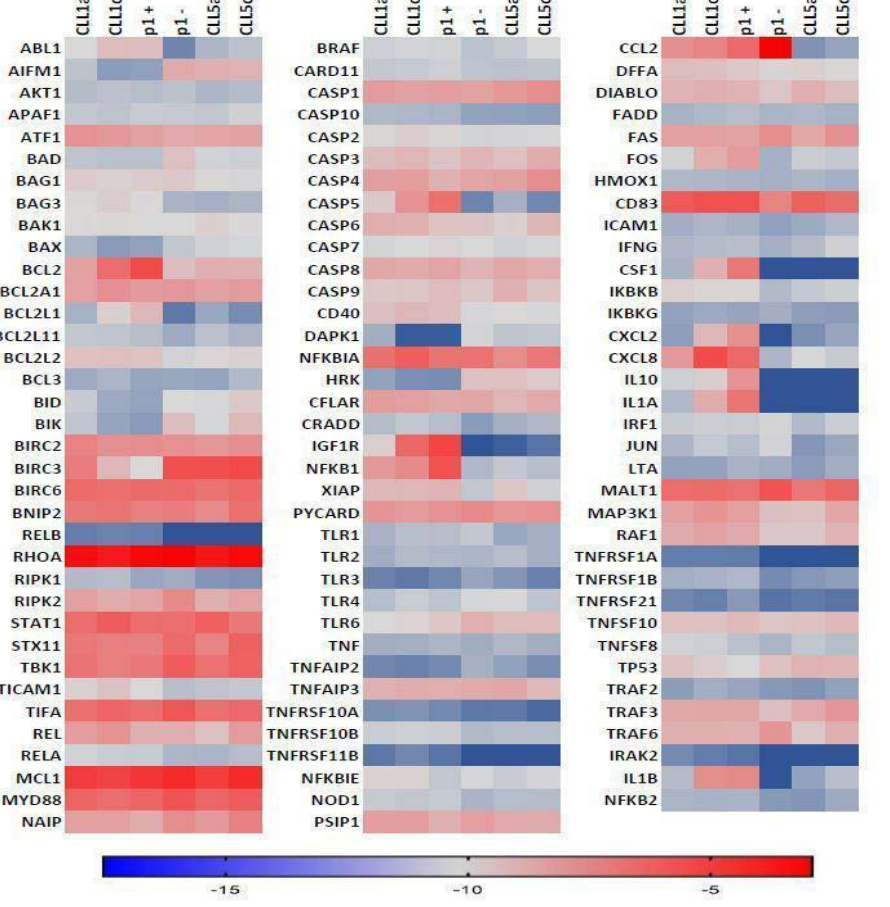
Figure 3. Heatmap of gene expression panel in bulk CLL1 (a, c) bulk CLL5 (a, c), p1-positive (p1+) cells, and p1-negative (p1 −) cells. CLL1a: CLL1 at month 1, indolent Binet A stage; CLL1c: CLL1 at month 8, aggressive Binet C stage; CLL5a: CLL5 at month 1, indolent Binet A stage; CLL5c: CLL5 at month 24, indolent Binet A stage; p1+: p1-positive, IGHV1-69 B-CLL cells; p1 − : p1-negative, non- IGHV1-69 B- CLL cells. ΔCt values of reference are reported in the bottom bar.